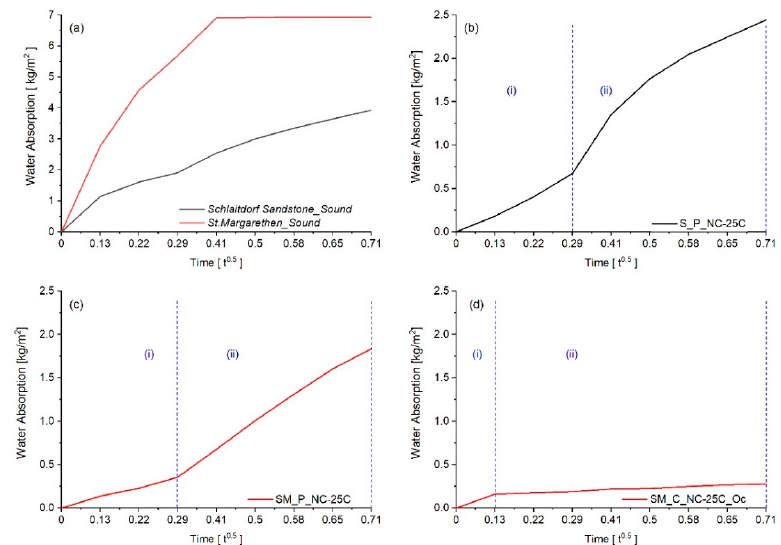
Figure 11. Examples of water absorption curves after 30 min (here reported as the square root of time in hours), extracted from gravimetrical monitoring. Graph ( a ) represents absorption curves from sound stone specimens, ( b ) Schlaitdorf Sandstone, ( c ) St. Margarethen Limestone where the consolidant NC-25C was applied by poultice and ( d ) a specimen of St. Margarethen Limestone representing the over-consolidation attained by a repetitive capillary absorption of NC-25C.